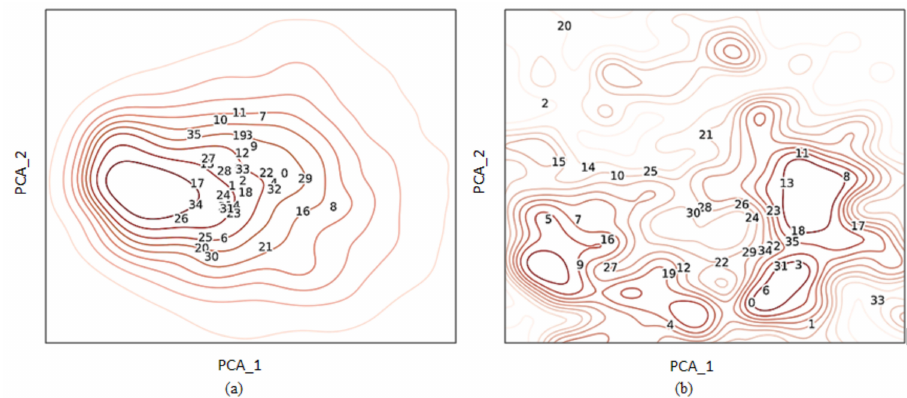
Figure 10. KDE plot for visualizing the separation of features received from ( a ) character images ( b ) fusion‑based approach (Dataset 15).